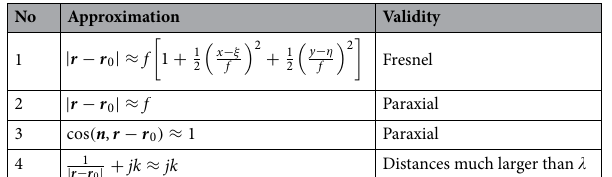
Distances much larger than Table 1. Summary of the approximations required to derive the UFT expression.